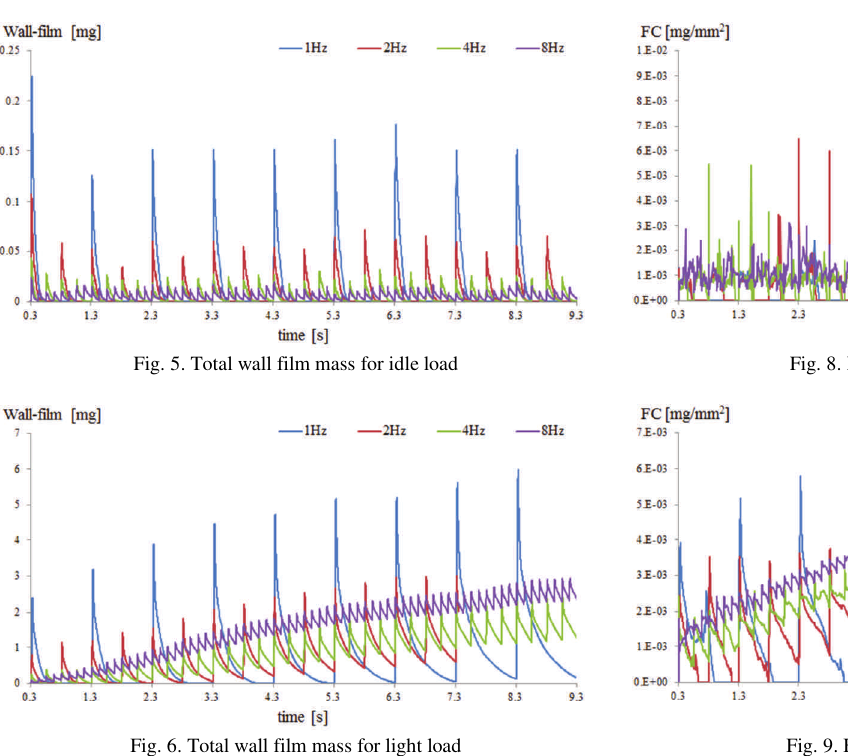
Fig. 6. Total wall film mass for light load